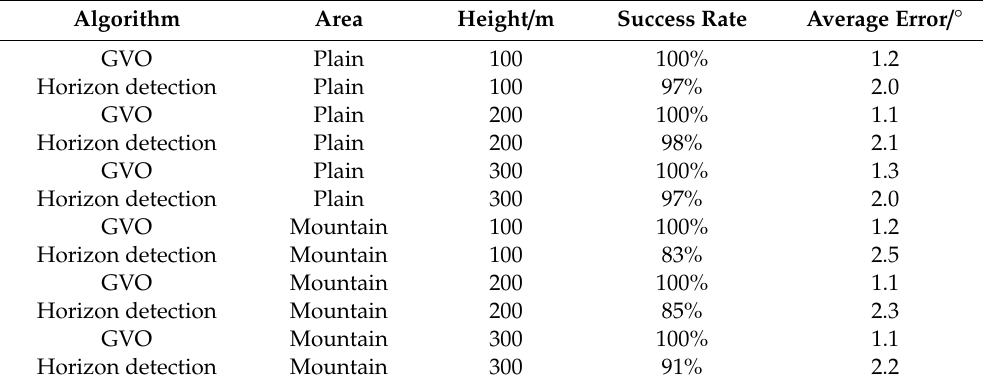
Table 4. Comparison between GVO (Visual Odometer integrated with GPS) and horizon detection method.